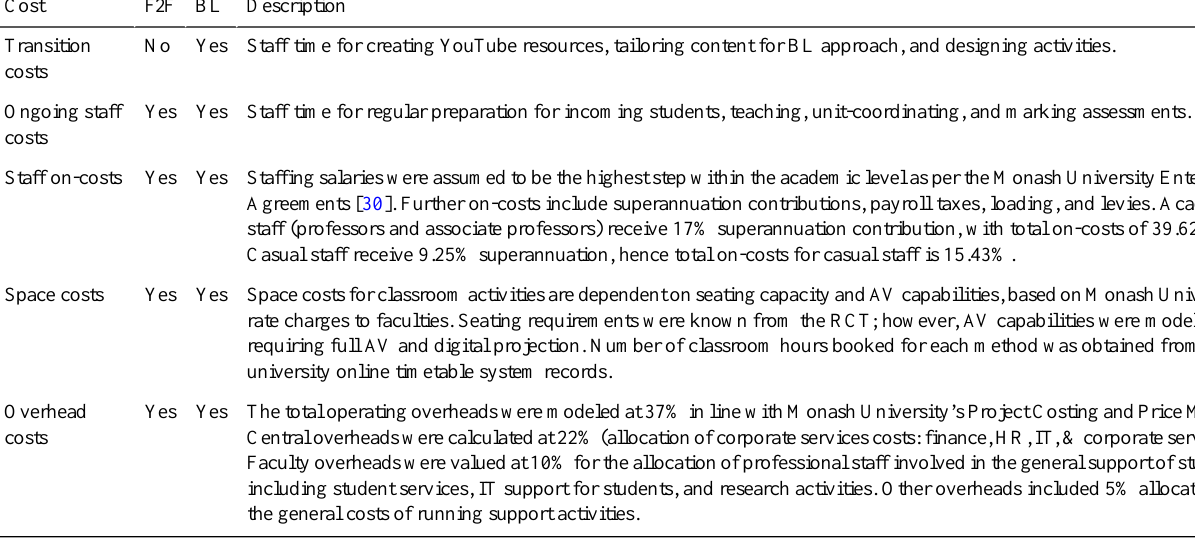
Table 2. Description of cost